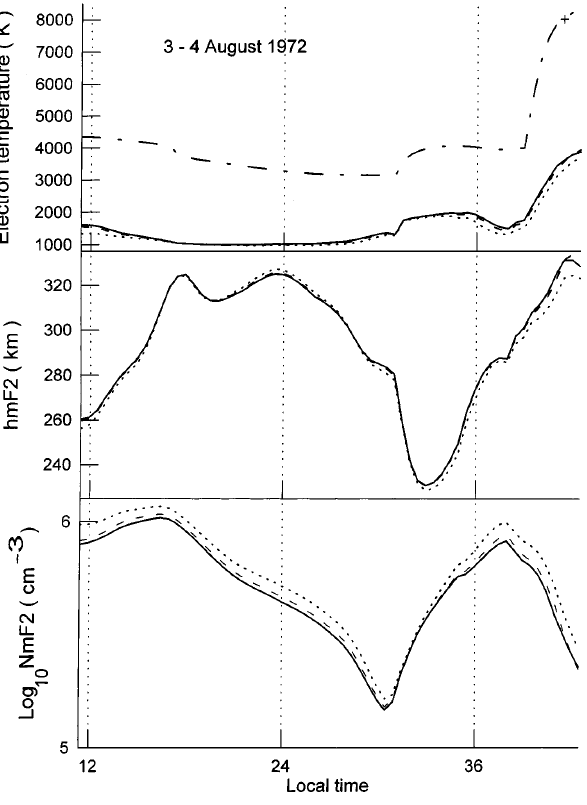
Fig. 5. The modelled NmF2 ( bottom panel ), hmF2 ( middle panel ), and electron temperatures at hmF2 and 1400 km ( top panel ) for the magnetically quiet and disturbed period 3–4 August, 1972. The modelled electron densities and temperatures were obtained with e(cid:128)ects of N 2 (cid:133) v (cid:134) and O 2 (cid:133) v (cid:134) ( solid lines ) on the O (cid:135) (cid:133) 4 S (cid:134) loss rate, and when N 2 (cid:133) v (cid:134) was not included in the calculations ( dashed lines ) of this loss rate. The dotted lines give results without e(cid:128)ects of N 2 (cid:133) v (cid:134) and O 2 (cid:133) v (cid:134) on the O (cid:135) (cid:133) 4 S (cid:134) loss rate. The dashed-dotted line represents the calculated electron temperature at 1400 km altitude. The ISIS II spacecraft measurement of the electron temperature in the SAR arc region at 05:51:51 UT on 4 August, 1972, at 1400 km is shown by a From the comparison between solid and dashed lines of Fig. 5 it follows that the increase in the O (cid:135) (cid:135) N loss 2 rate due to vibrationally excited N produces the 5–19% 2 reductions in the calculated quiet daytime peak density and the 16–24% decrease in NmF2 in the SAR arc region. The comparison of dashed-dotted and dashed rate factor lines show that the increase in the O (cid:135) (cid:135) N 2 due to the vibrationally excited oxygen produces the 7– 26% decrease in the calculated quiet daytime peak arc region. It should be noted that there is a large and N . The resulting e(cid:128)ect on the NmF2 is a excited O 2 2